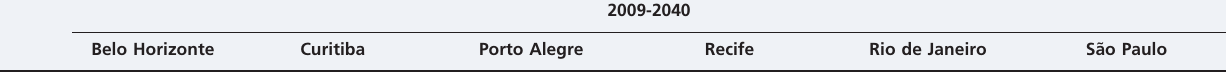
Table 5 - Total costs in US$ of the hospital admissions (PHS and PrHS) due to respiratory and cardiovascular diseases attributable to PM2.5 between 2009-2040 in the six metropolitan areas.